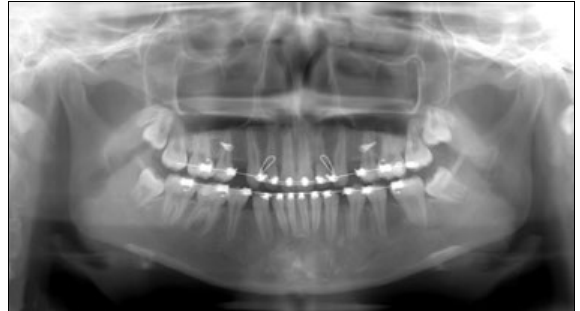
Figure 7. Panoramic radiograph nine months after enucleation. The space in the mandibular left first molar was almost closed, and no recurrence was